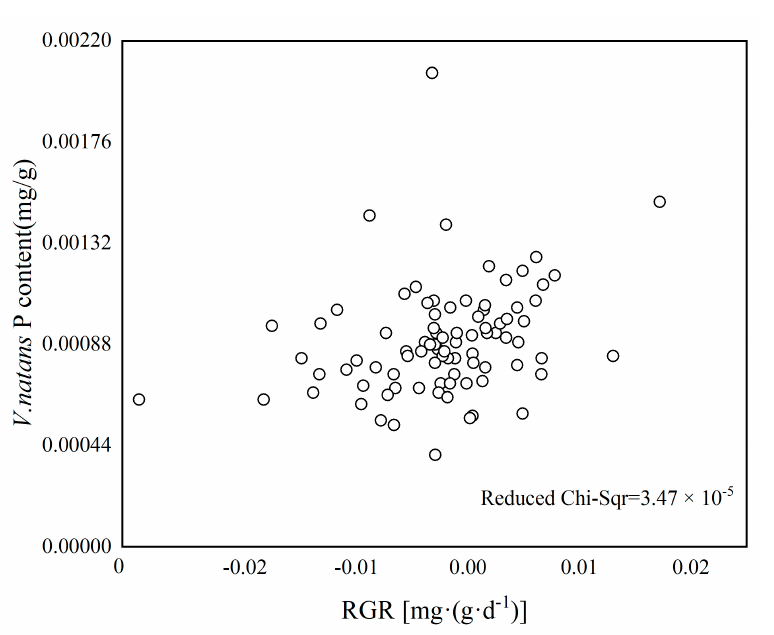
Figure 7. The relationship between V. natans P and relative growth rate (RGR). Figure 9. The relationship between V. natans C:P and relative growth rate